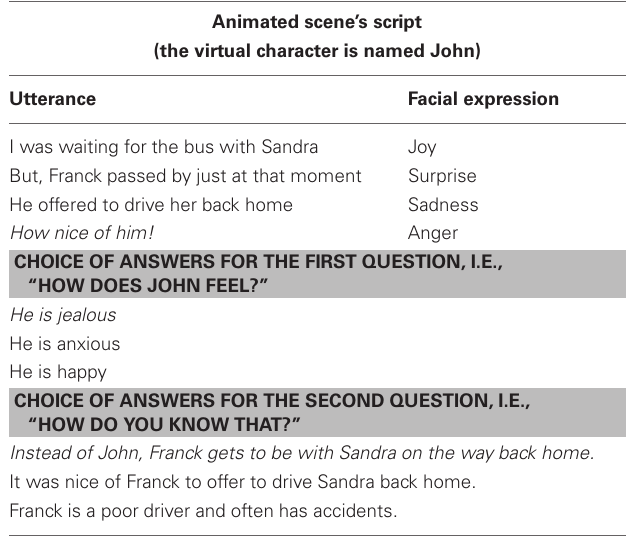
FIGURE 1 | The gaze-controlled viewing window: the graphic display is entirely blurred except for an area centered on the focal point of the participant, which is detected in real-time using an